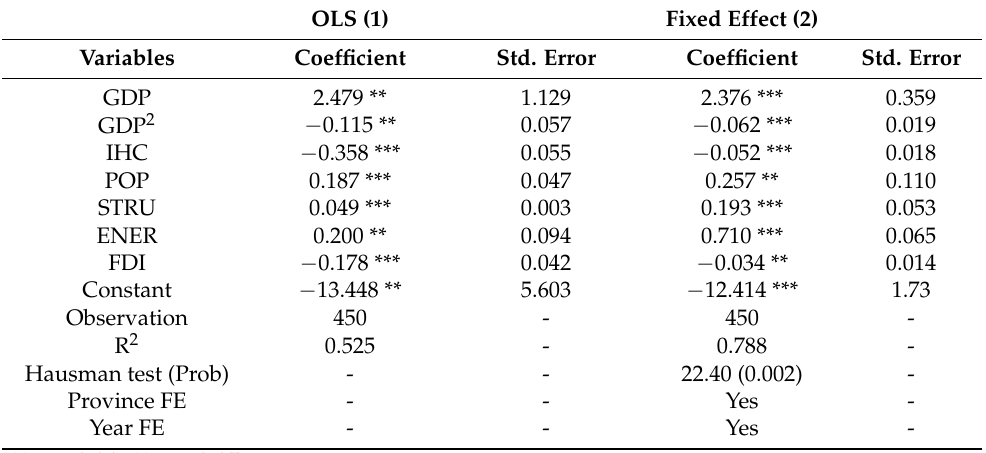
Table 6. Regression